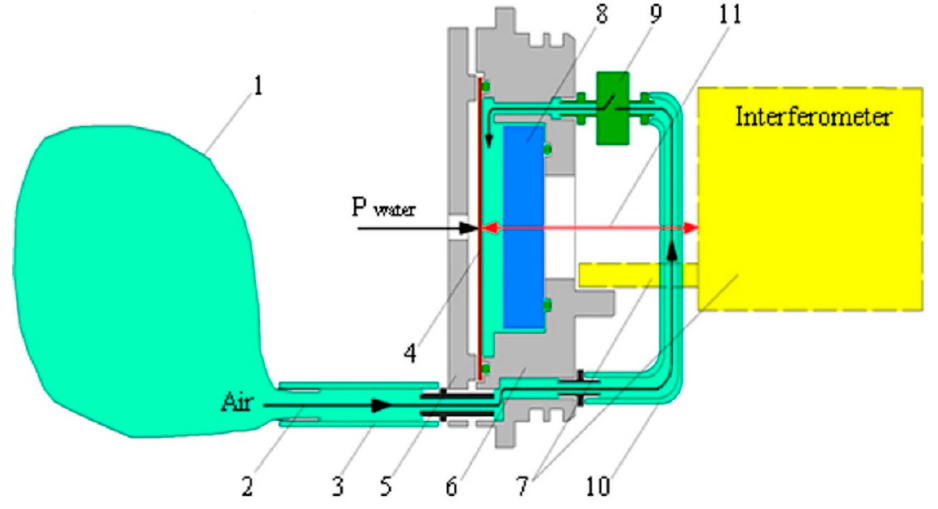
Figure 2. Scheme of external pressure compensation system. 1—air-filled container, 2—direction of air movement, 3—connecting tube, 4—membrane, 5—membrane protection, 6—removable cover base, 7—interferometer, 8—optical window, 9—valve, 10—connecting tube, 11—laser beam.